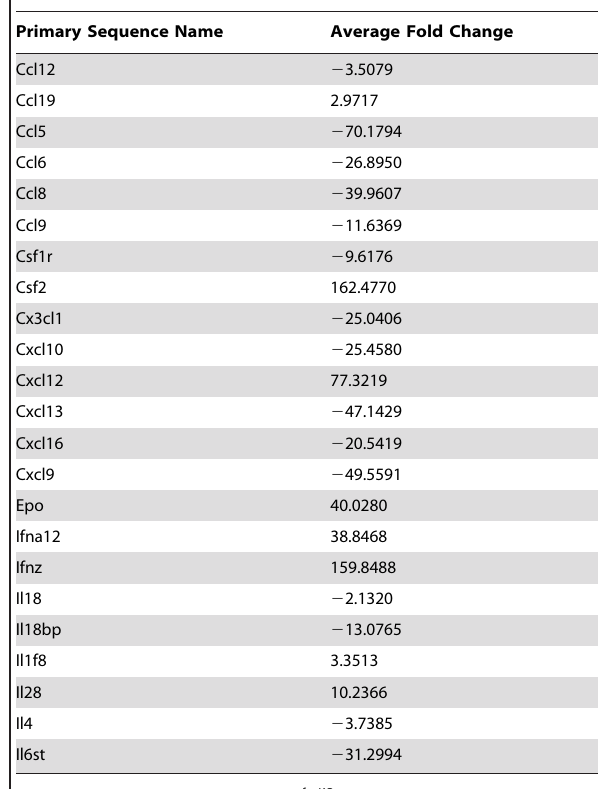
Table 1. Selected List of